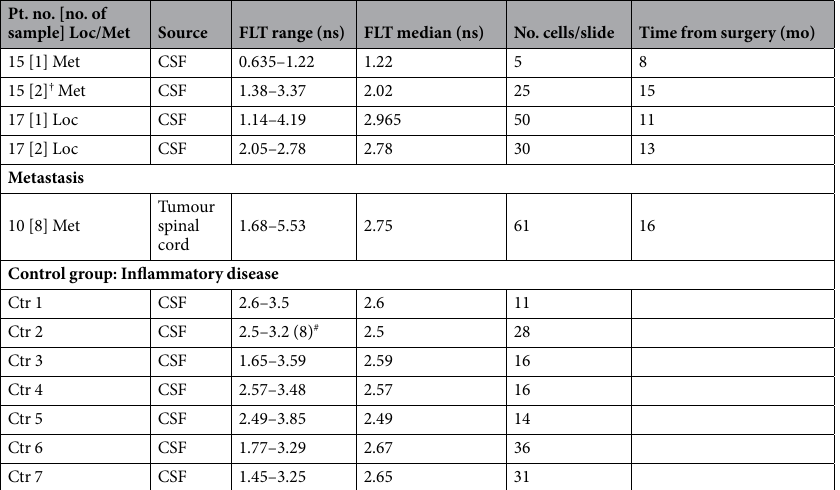
Table 2. FLT of each slide, obtained using FILM measurements, per patient categorised according to stage of treatment (at diagnosis, before chemo/radiotherapy, during chemo/radiotherapy, after chemo/radiotherapy) and per patient of control group: inflammatory disease. * After chemotherapy, before radiation. † Six months after completion of radiation. # Only one cell out of 28 examined was high as 8. FLT, fluorescence lifetime, CSF, cerebrospinal fluid, Loc, localised, Met,